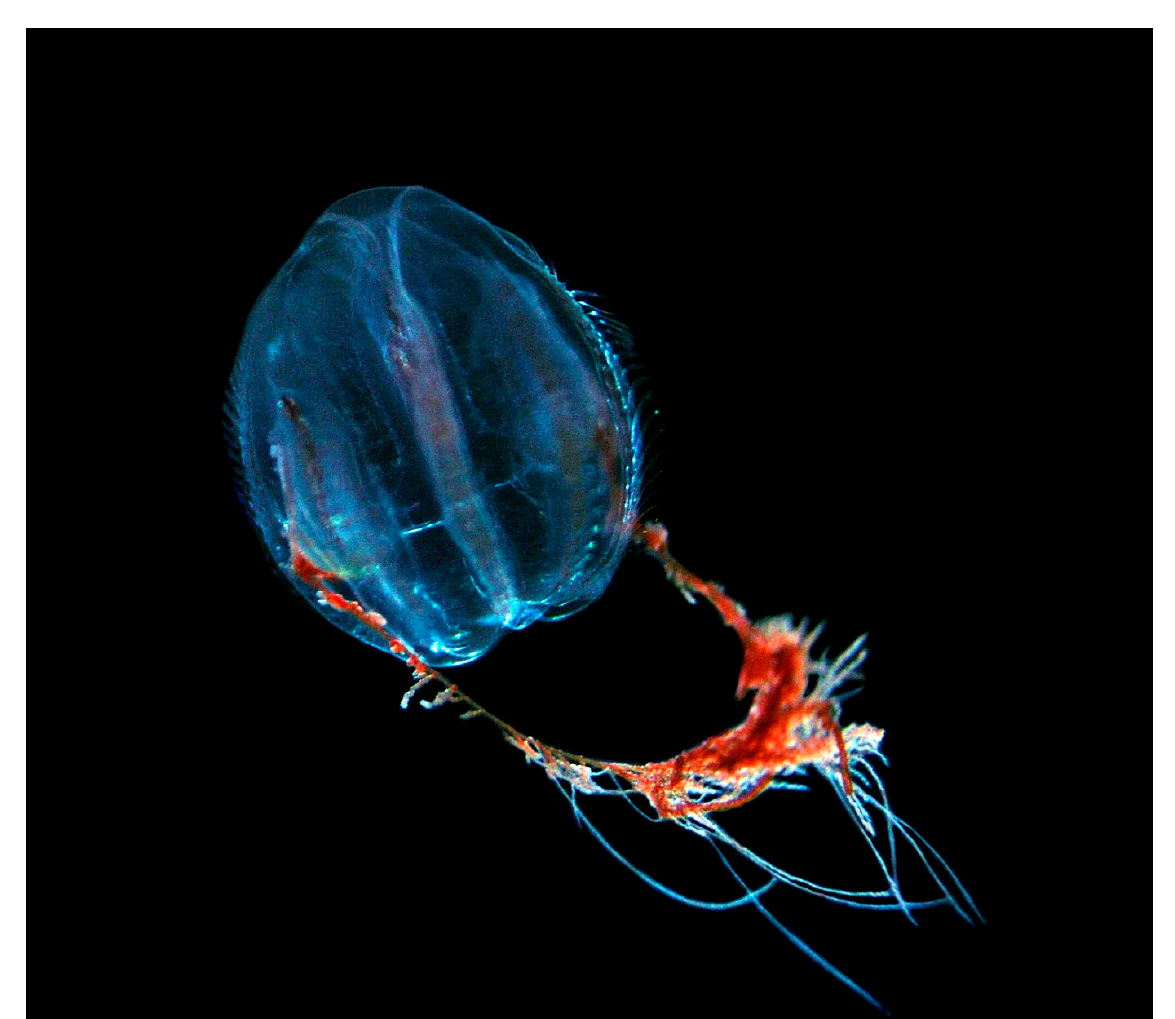
Figure 8. Native comb jelly Mertensia ovum , which is only present as larvae in the Baltic Sea. 5 mm M. ovum from West Greenland waters. Image credit: C. Jaspers.